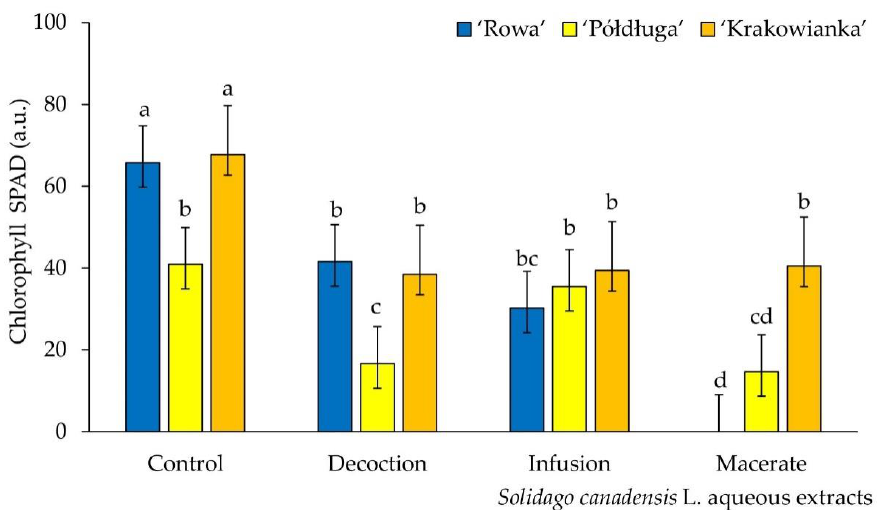
Figure 2. Chlorophyll content of radish seeds ( Raphanus sativus L. cv. Rowa, Półdługa, Krakowianka) treatment of aqueous extracts from Solidago canadensis L. leaves; mean values ± SD ( n = 10) with different letters (a–d) differ statistically according to Duncan test at p < 0.05.